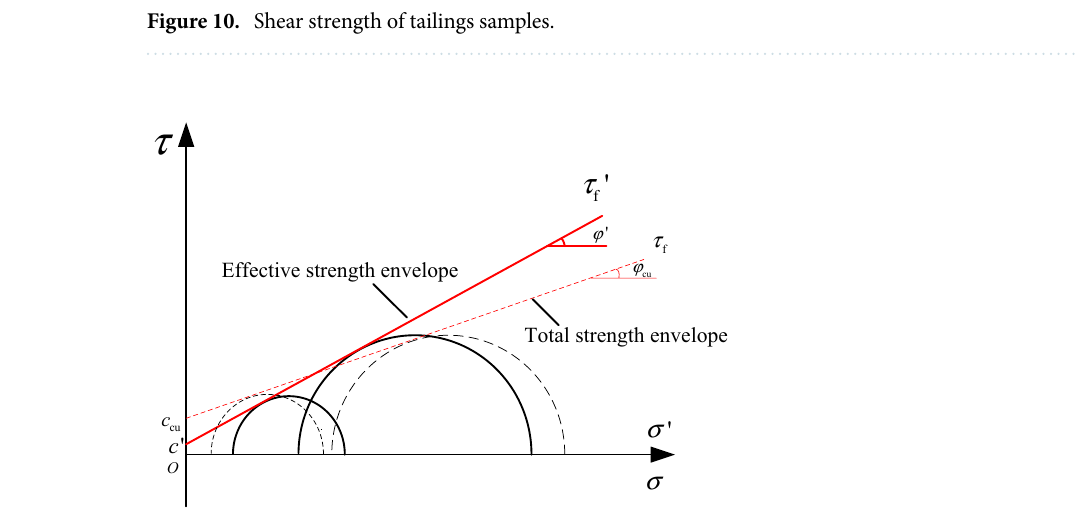
Figure 10. Shear strength of tailings samples.